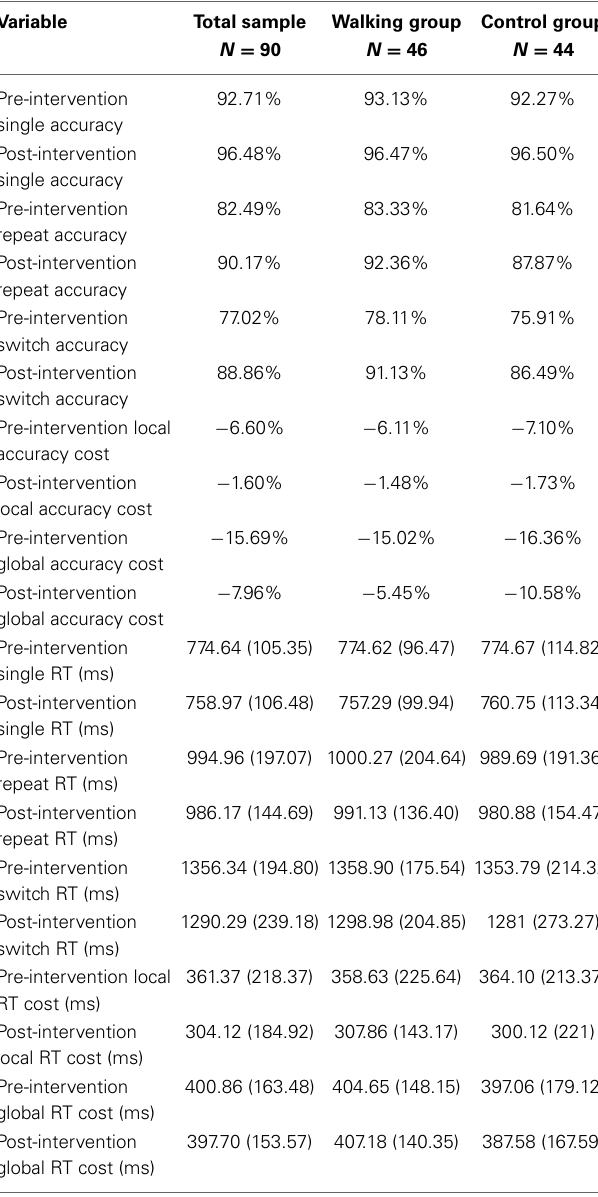
Table 2 | Task-switch performance. Table 3 | Age moderates effect of exercise group on BDNF serum levels at